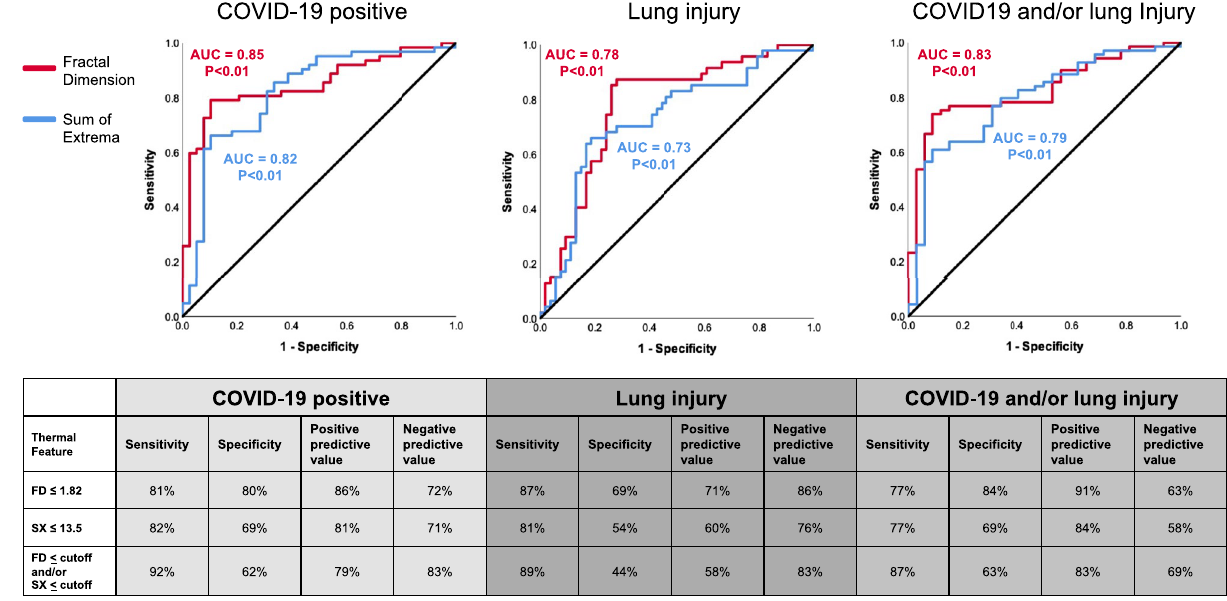
Figure 3. The diagnostic yields of thermal imaging scores in detection of COVID-19 and lung injury. Receiver operating characteristic (ROC) curves are shown (top panel) for the three different clinical classifications. Sensitivity and specificity values were calculated for select cutoffs (bottom